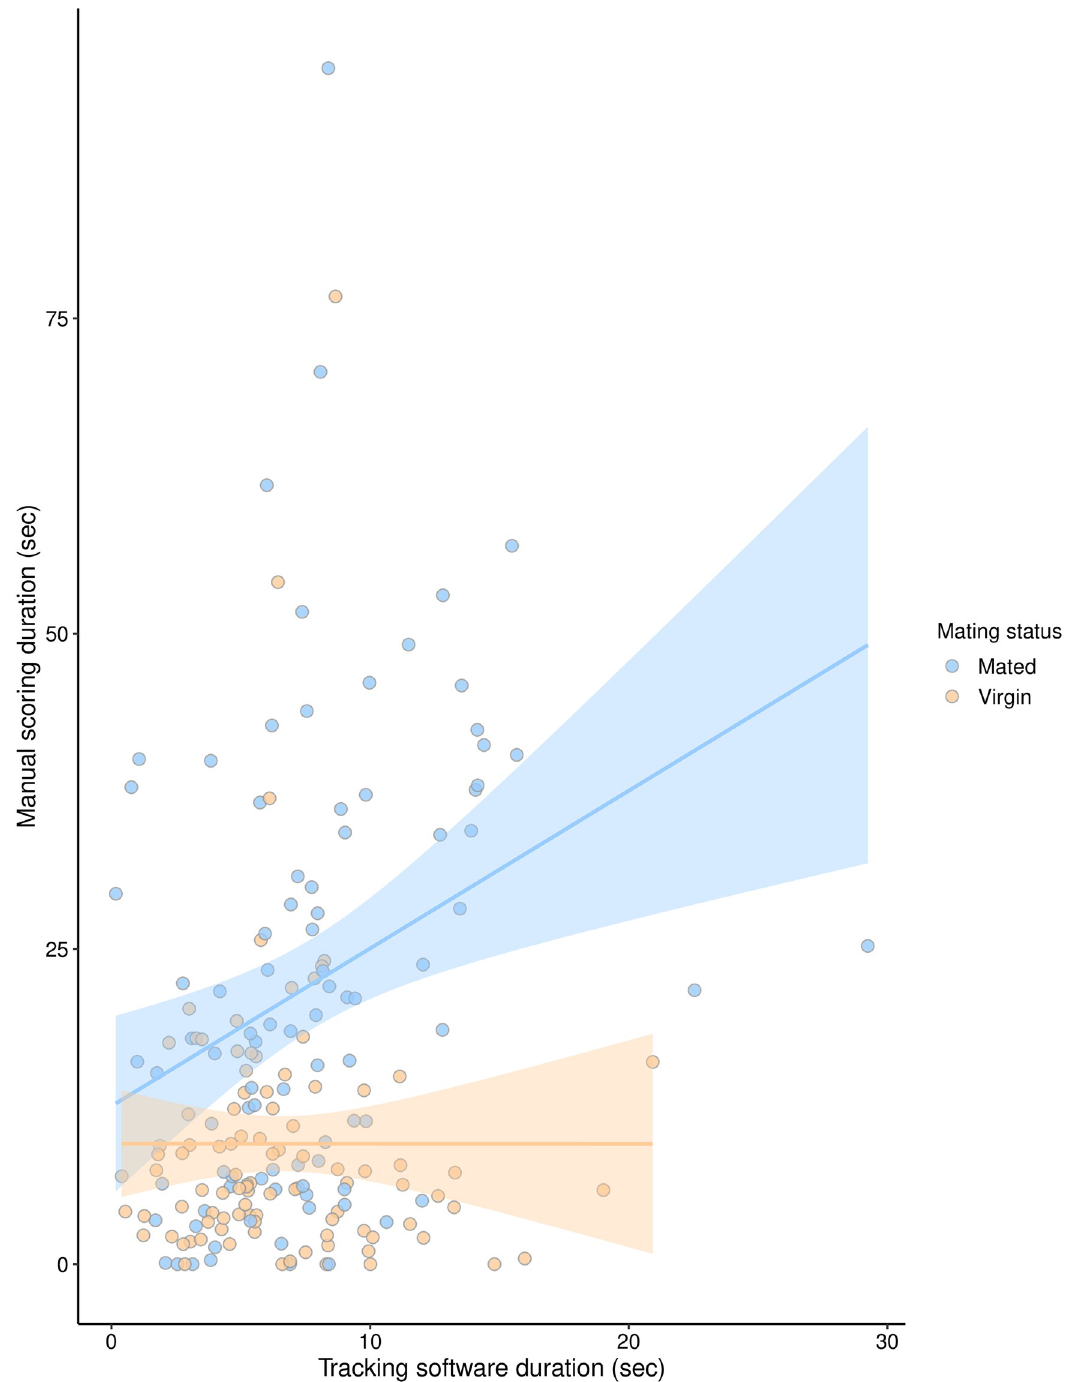
Fig 3. Manual and tracking data are positively correlated for mated females but not for virgin females. Blue points represent mated females from all treatments, while yellow points represent virgin females from all treatments. Each point represents the contest duration for one pair of females. The lines indicate the linear model fit between the manual scoring and tracking data for mated (blue) and virgin (yellow) females separately. The highlighted areas around the line indicate the 95% confidence interval.